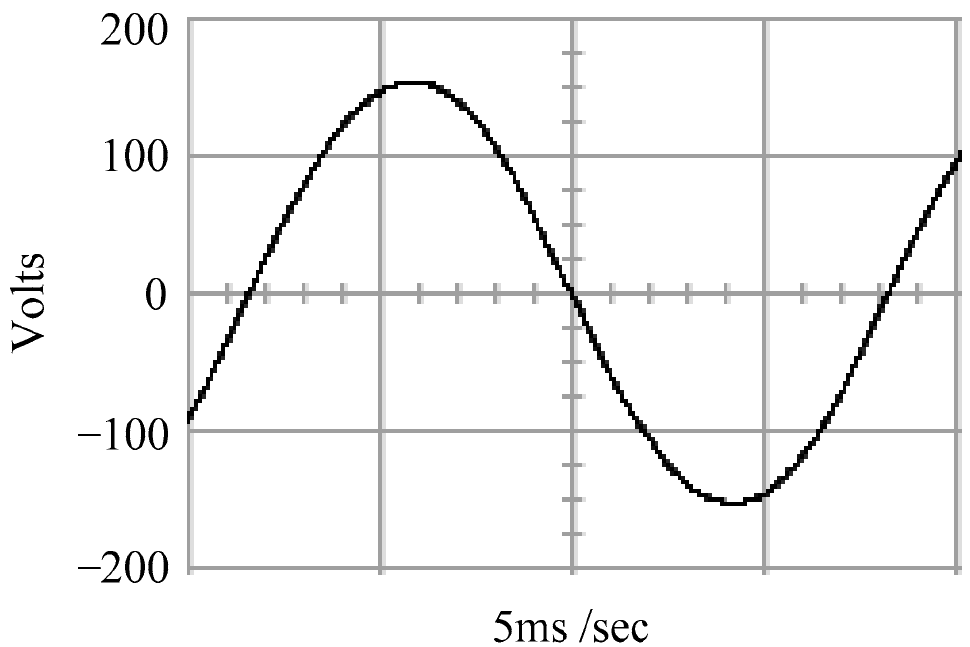
Figure 8. Circuits of hardware implementation.